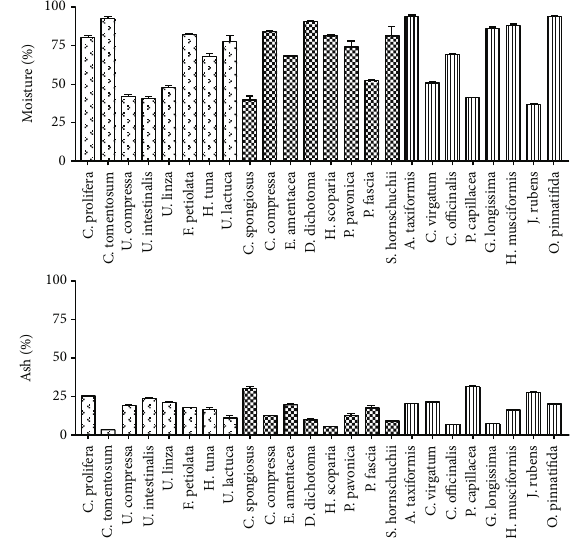
Figure 2: Proximate composition of moisture and ash expressed as percentage (%) of seaweeds collected from the Tripoli